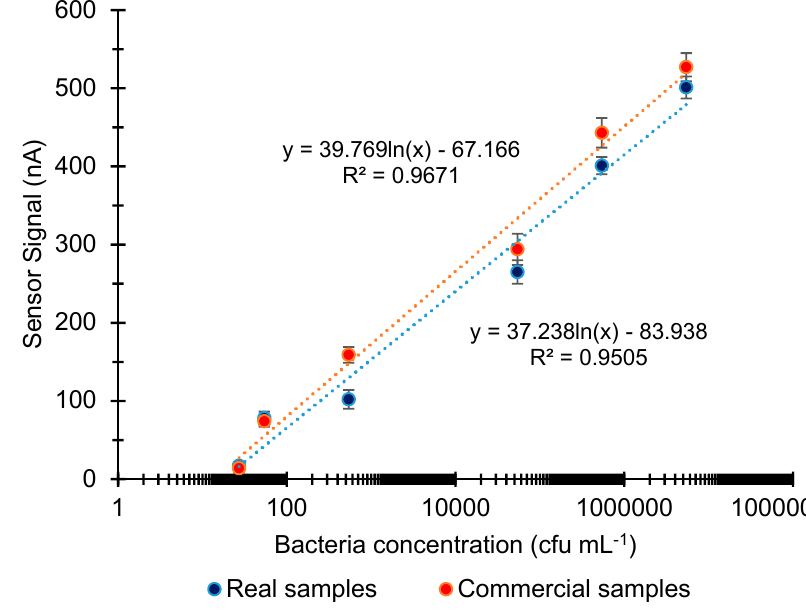
Figure 5. Overall results of Salmonella detection in a concentration range of 27–5.41 × 10 7 using a standard sandwich assay (n = 6).